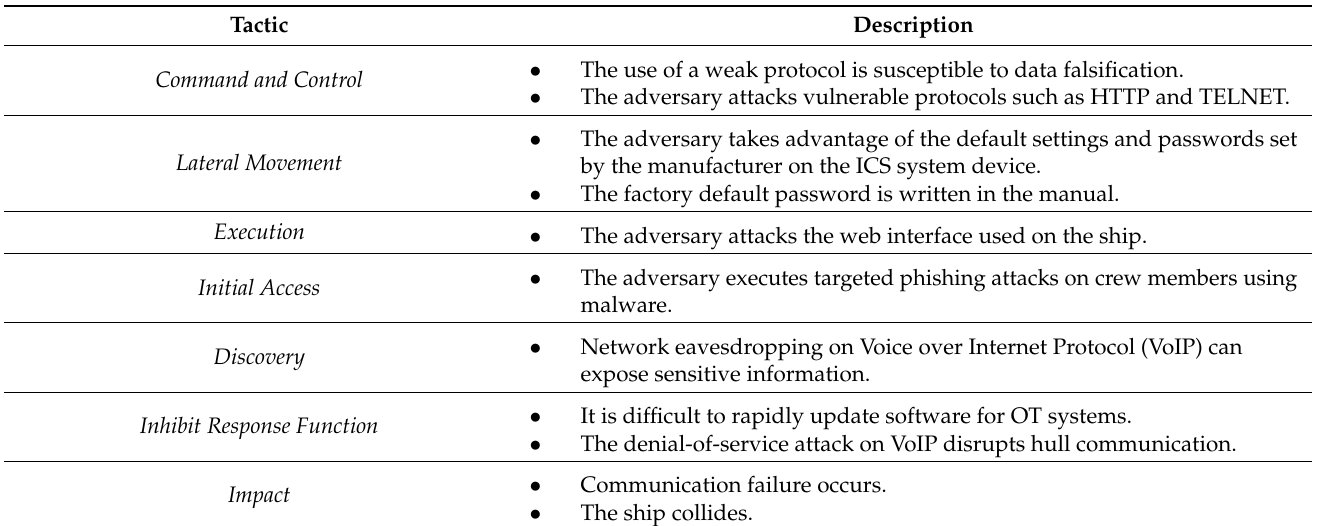
Table 7. Communication system analysis results.